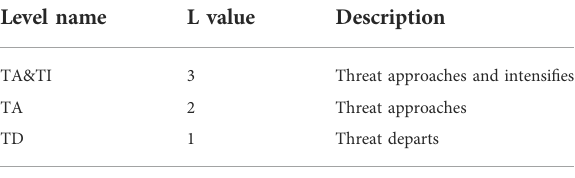
TABLE 1 Types of dynamics of threat to giant panda